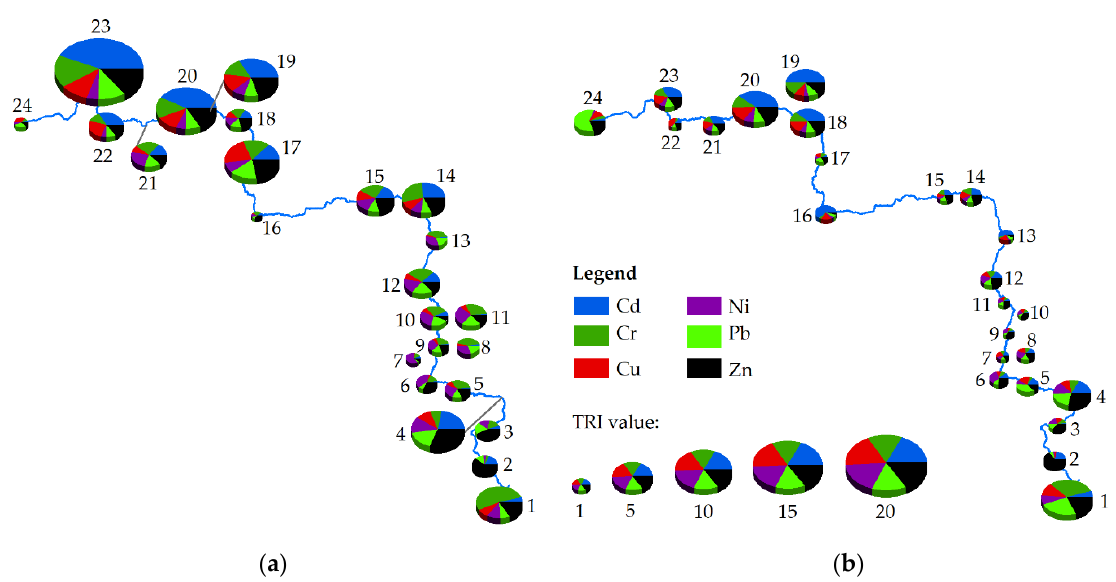
Figure 10. Toxic Risk Index (TRI) in bottom sediments of Warta River in 2016 ( a ) and 2017 ( b ).